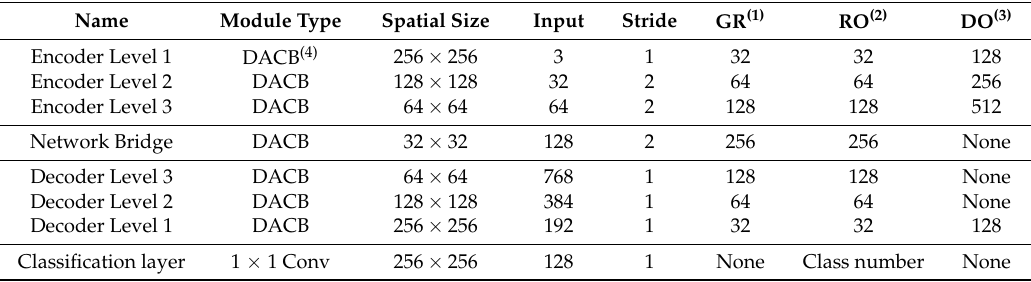
Table 2. JointNet